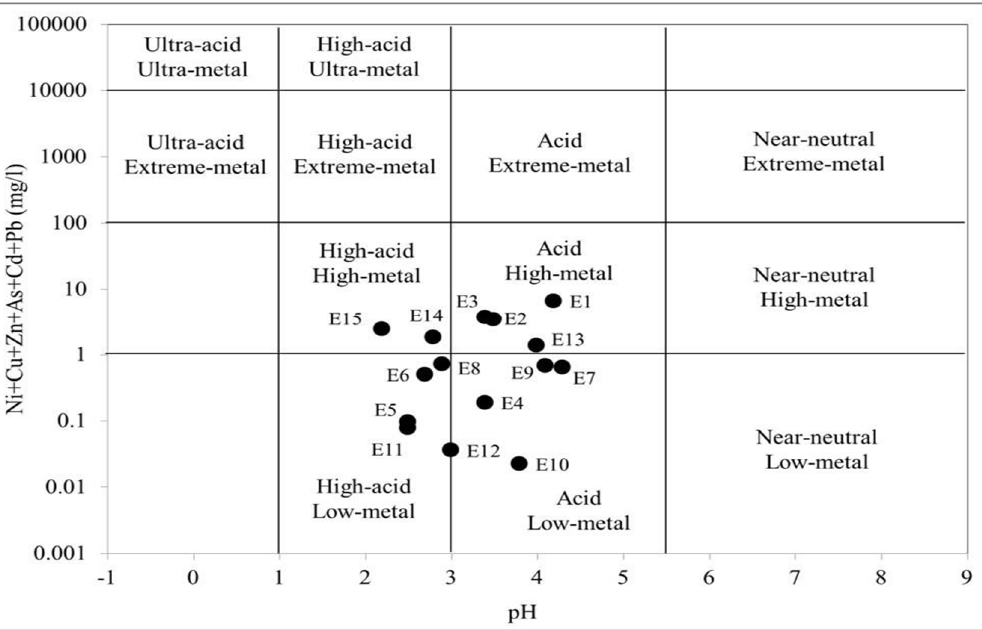
Figure 4. Metal(loid)s with pollution potential according to WHO guidelines for drinking water [46] content of leachates of the studied salt efflorescences: Ficklin diagram.